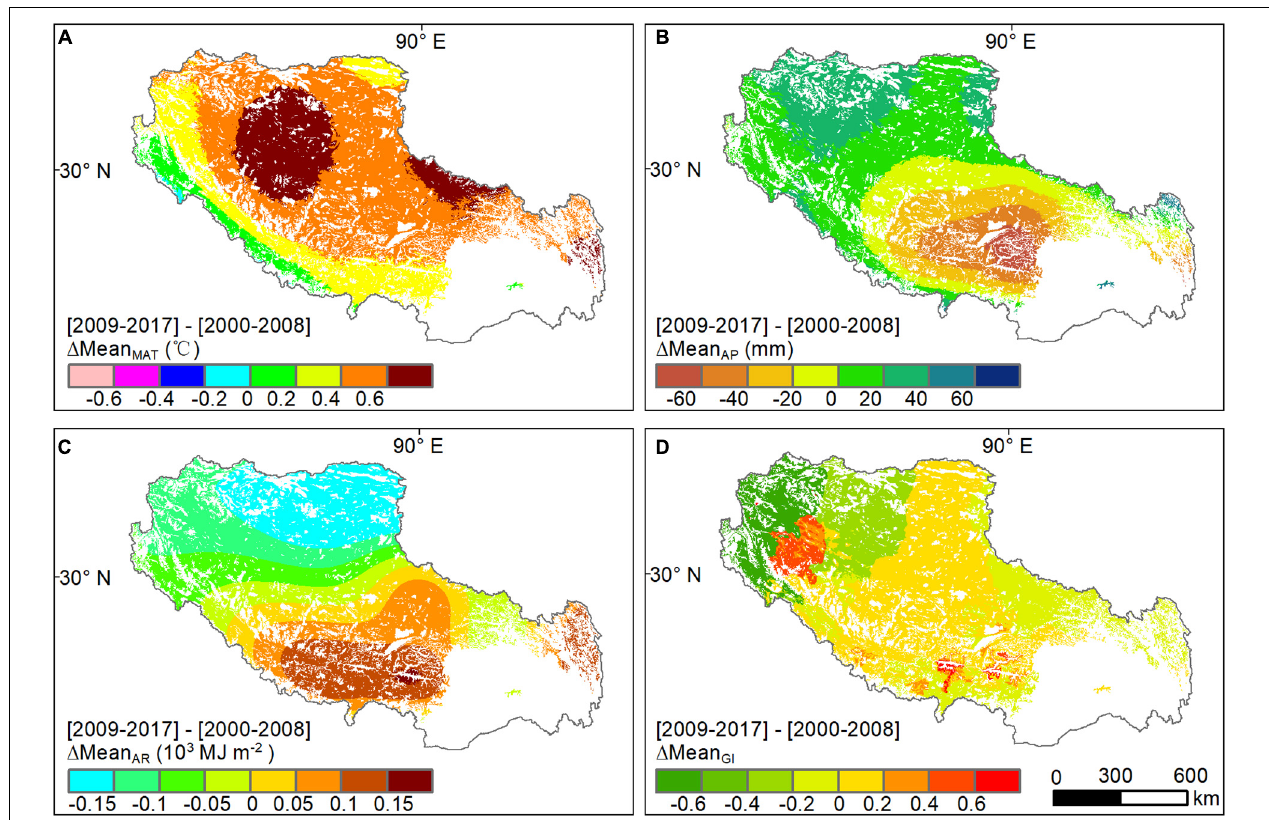
FIGURE 4 | Distribution of the mean-difference in (A) MAT, (B) AP, (C) AR, and (D) GI between before and after the implementation of the “ Ecological Security Barrier Protection and Construction Project .”